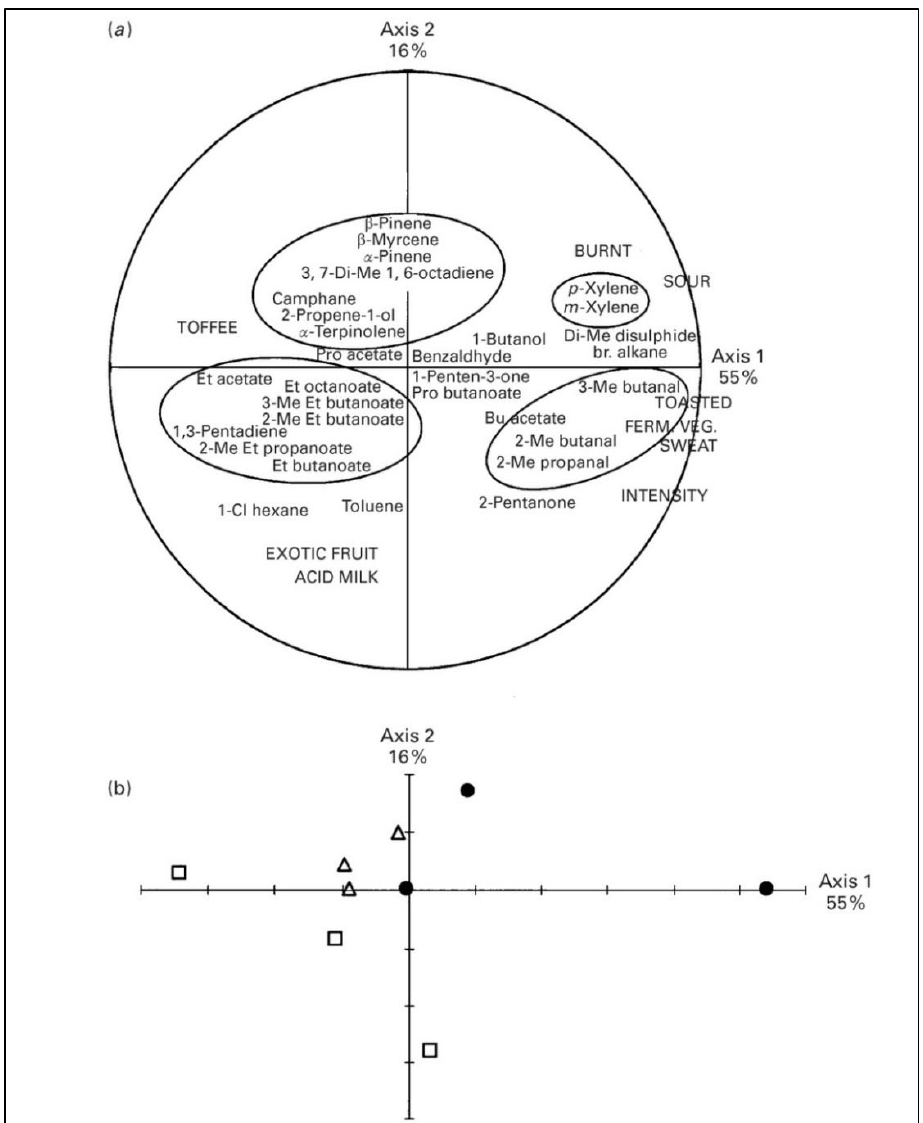
Figure 4. Principal component analysis (PCA) of the aroma characteristics of the cheeses: plot of principal axes 1 and 2. ( a ) Correlation circle. Aromas are represented in capitals. Volatile compounds that varied significantly ( p < 0.05) between series of cheeses by analysis of variance are added as additional variables. Compounds of the same chemical family, characteristic of a series of cheeses, are included in ovals. FERM. VEG. = fermented vegetable; Bu = butyl; Cl = chloro; Et = ethyl; Me = methyl; Pro = propyl; br = branched. ( b ) Representation of the experimental cheeses from north and south areas in the study: ∆ = south 1 cheeses; □ = south 2 cheeses; ● = north side cheeses [27].